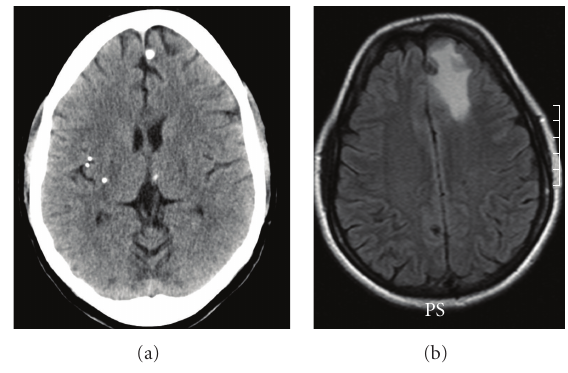
Figure 1: (a) Baseline CT scan demonstrating a dense calcification in the left frontal lobe as well as other calcifications. (b) MRI images that used fluid attenuated recovery after the patient had a seizure revealing perilesional